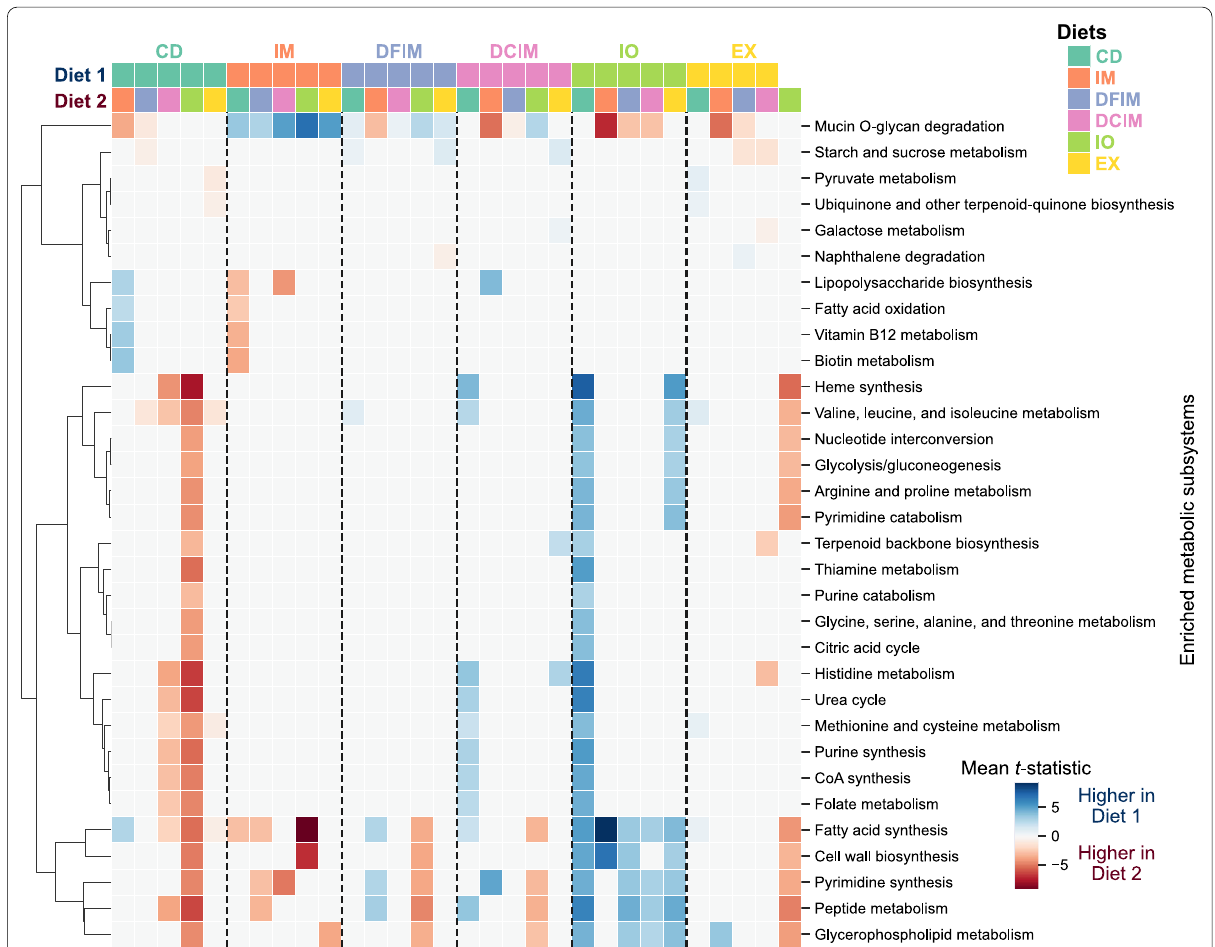
Fig. 8 Hierarchical clustering of the significantly enriched metabolic subsystems between each pair of dietary groups. Columns are diet pairs, rows are metabolic subsystem, and the color of each cell indicates whether the metabolic subsystem was enriched in diet 1 (blue) or diet 2 (red). CD control diet; IM full-fat BSF (black soldier fly) larvae meal diet; DFIM defatted BSF larvae meal diet; DCIM de-chitinized BSF larvae meal diet; IO BSF larvae oil diet; EX BSF larvae exoskeleton